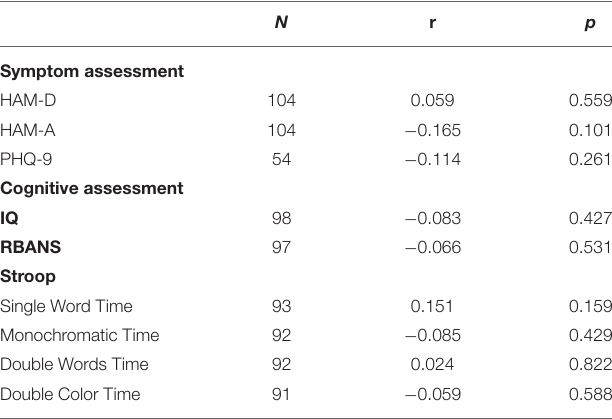
TABLE 2 | Associations between plasma D β H activity and clinical or cognitive assessments in patients with MDD.